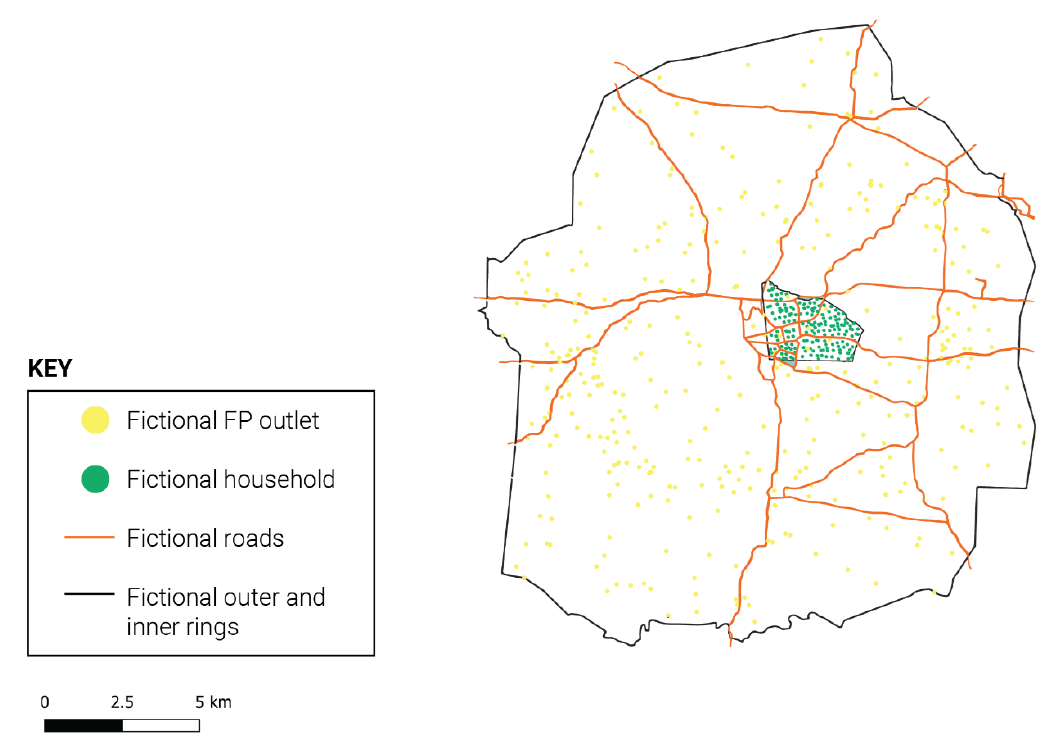
Figure 1. Illustration of outer and inner ring design (hypothetical study